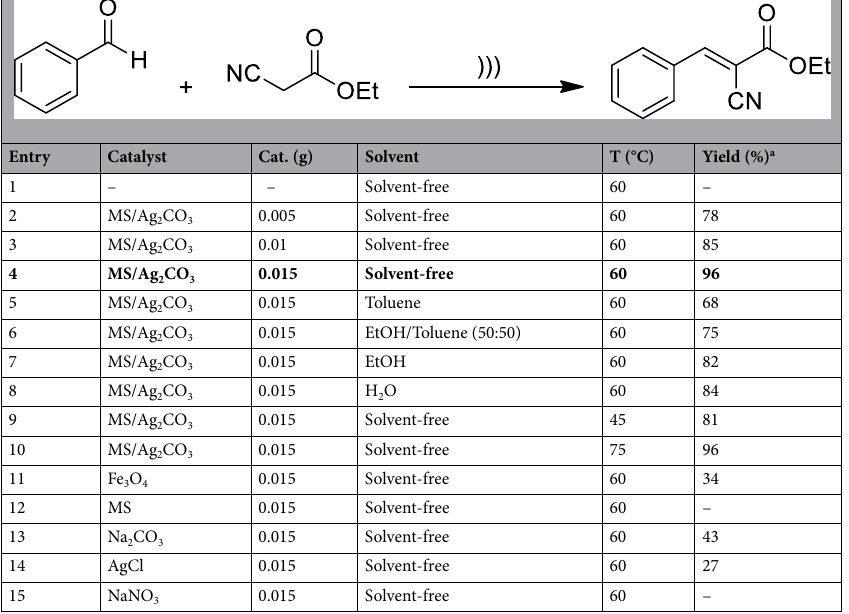
Table 1. The effect of catalyst, solvent and temperature in the Knoevenagel condensation. a Reaction